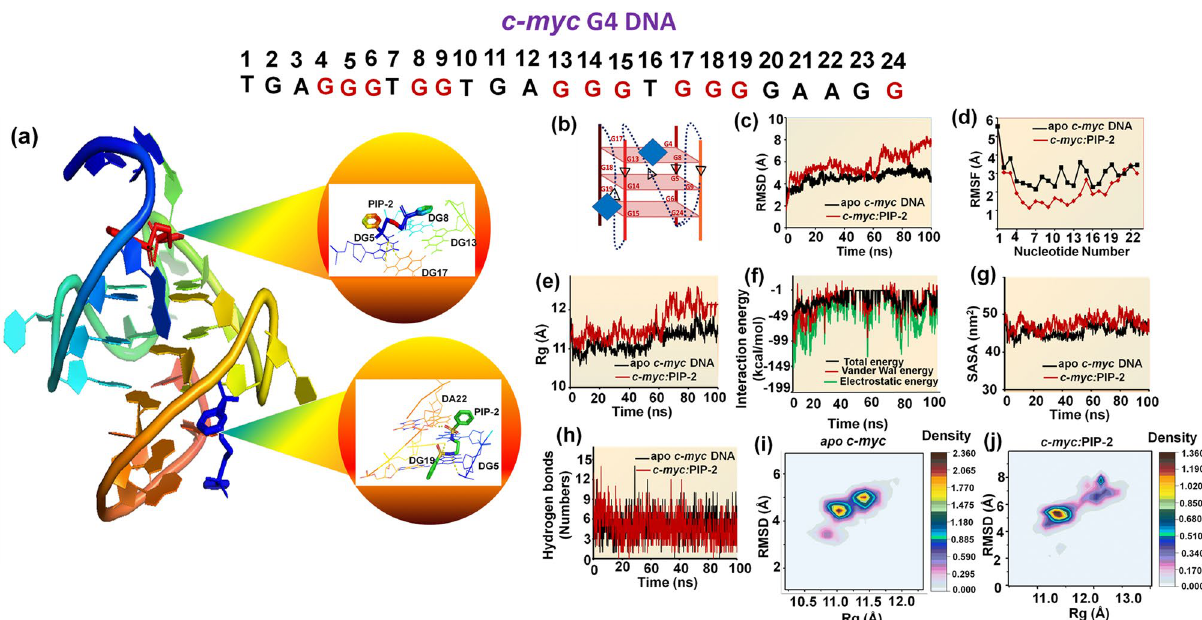
Figure 7. Molecular docking and simulation analysis of c-myc G4 DNA with Piperine analog PIP-2 ( a – c ). ( a ) Docked PIP-2 with the G-quadruplex structure formed in the c-myc promoter region. One PIP-2 molecule interacts with the c-myc G4 DNA by stacking on the upper tetrad of (G4–G8–G13–G17) and while the second molecule interacts with the groove region of G-quadruplex DNA. Inset shows the enlarged image of molecular interaction between the PIP-2 and the c-myc G4 DNA. ( b ) Schematic representation of the docking between PIP-2 (dark blue) and c-myc G4 DNA. ( c ) A plot of RMSD of all atoms vs. time for apo c-myc G4 DNA, and c-myc -PIP-2 DNA complex. ( d ) Root Mean square fluctuation (RMSF) ( e ) Radius of gyration (Rg) ( f ) interaction energy ( g ) Solvent accessibility surface area (SASA) ( h ) Number of hydrogen bond were evaluated for both apo c-myc DNA and c-myc -PIP-2 complex. ( i ) The graphs represent the 2D PMF free energy landscapes for the apo c-myc and ( j ) c-myc -PIP-2